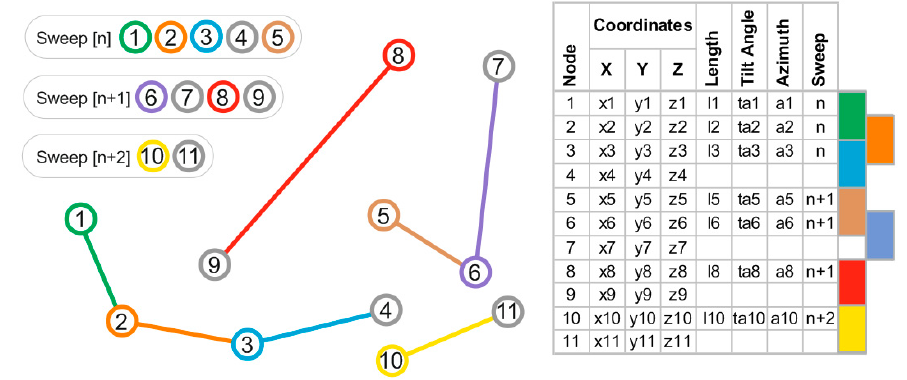
Figure 3. Example of line cloud data storage of lines from three different sweeps: (n), (n+1) and (n+2). Points 1–11 are hypothetical consecutive points. The points are split into four different polylines: (1–2–3–4), (5–6–7), (8–9) and (10–11). The polylines are divided into seven straight lines, which are stored as shown in the table.